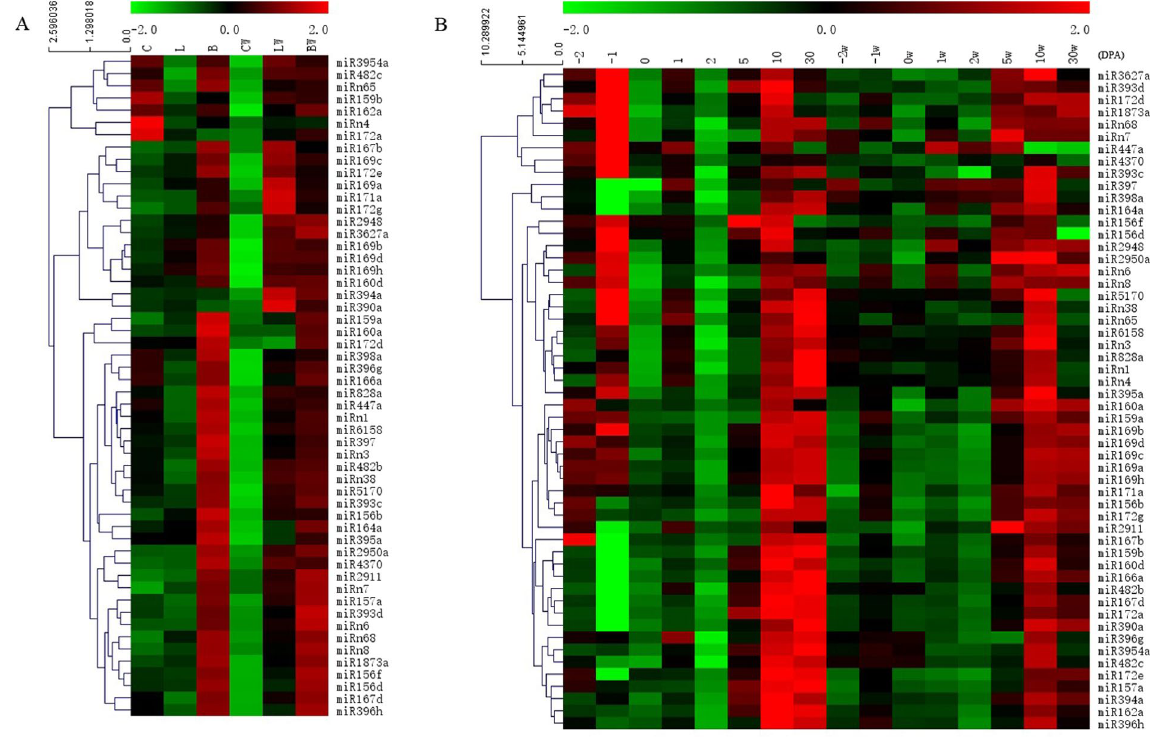
Figure 4. Heatmap of miRNAs expression profile in all investigated tissues. The ranking of expression was showed using different colors: higher expression was designed red; median expression black, reduced expression green; ( A ) miRNAs expression profile in non-fiber tissues; ( B ) The expression of tested miRNAs in fiber development stage of fiberless mutants and its wildtype.